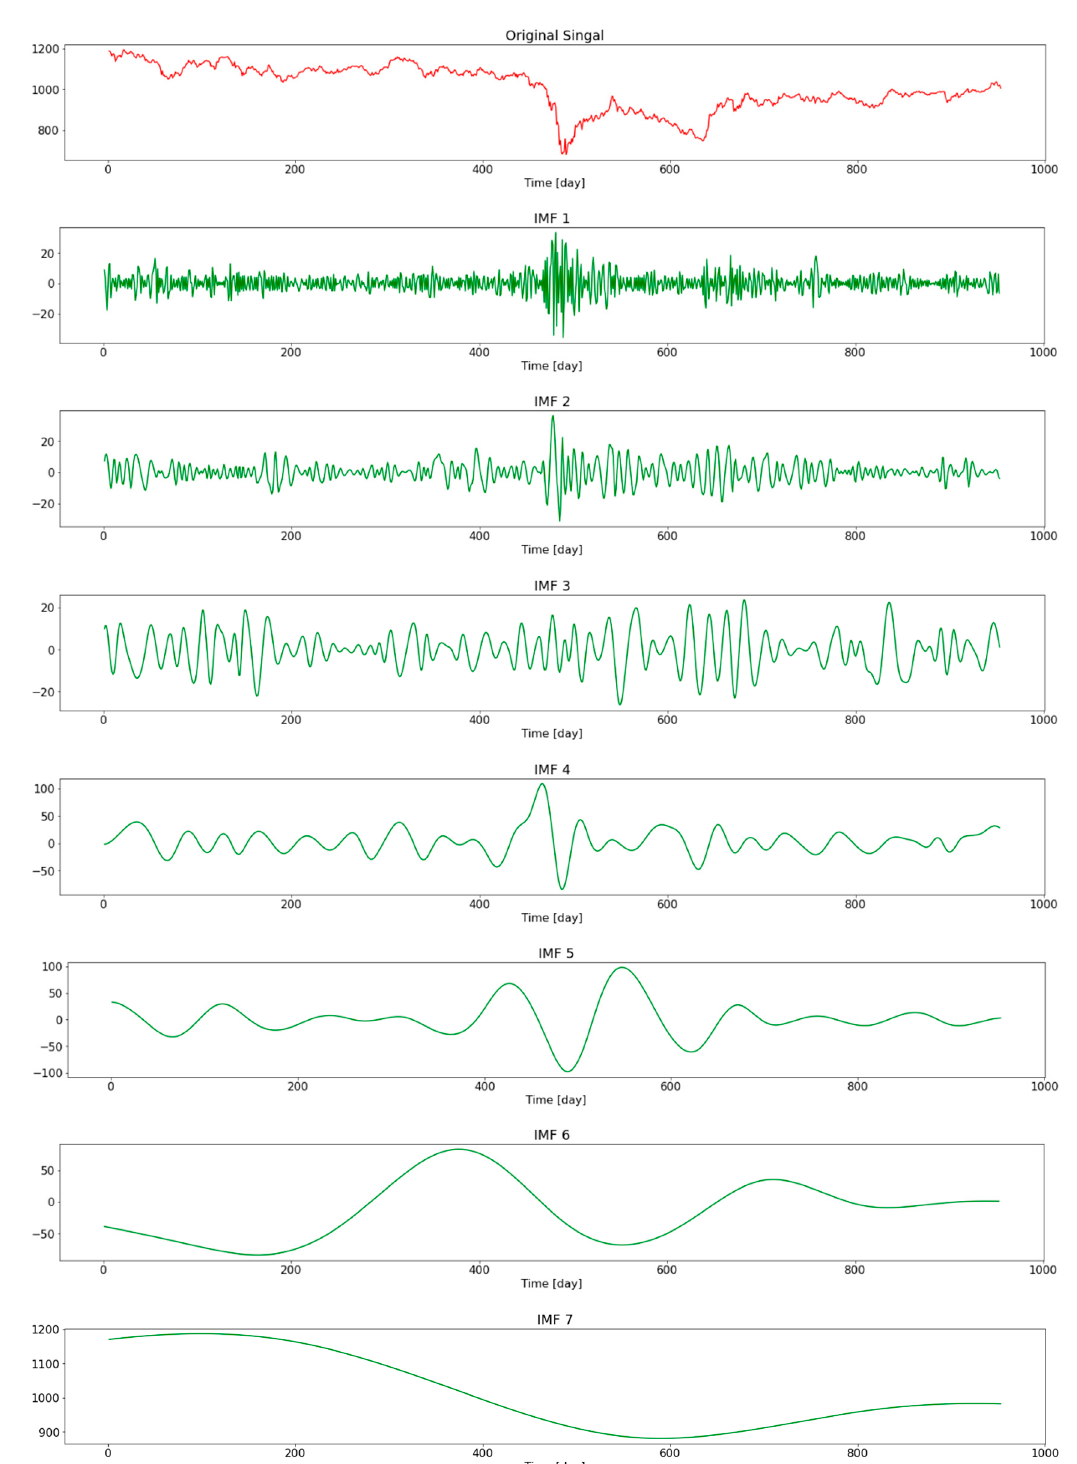
Figure 7. The original closing price and decomposed IMFs.